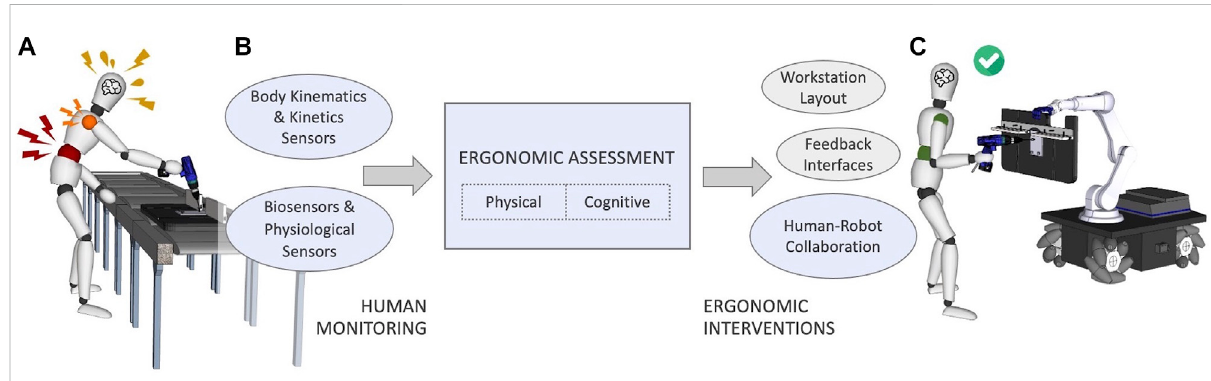
FIGURE 1 A conceptual illustration of a worker accomplishing an industrial task without (A) and with (C) a collaborative robotic solution. The structure of this article is also described in the schema (B) , highlighting (blue) the research themes that we focus